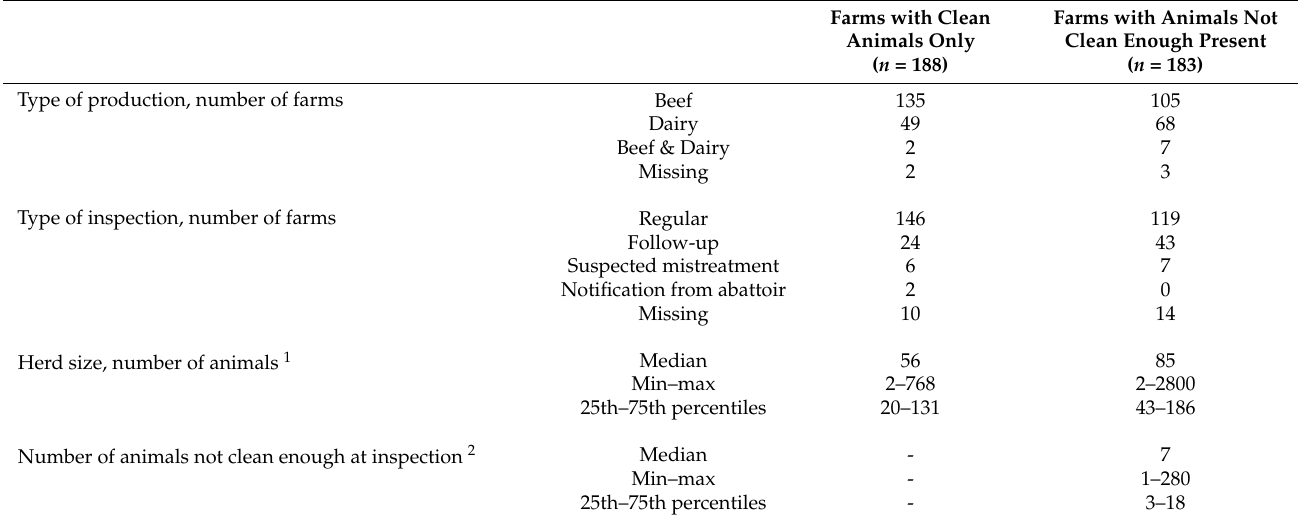
Farms with Clean Animals Only